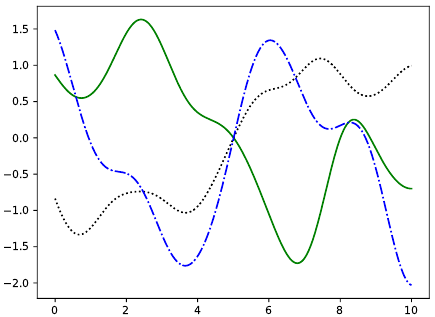
Figure 3. Five samples drawn from the posterior, conditioned on a noise-free observation at x = 5, y = 0 (squared exponential kernel, length-scale (cid:96) = 1). Note that all samples pass through that